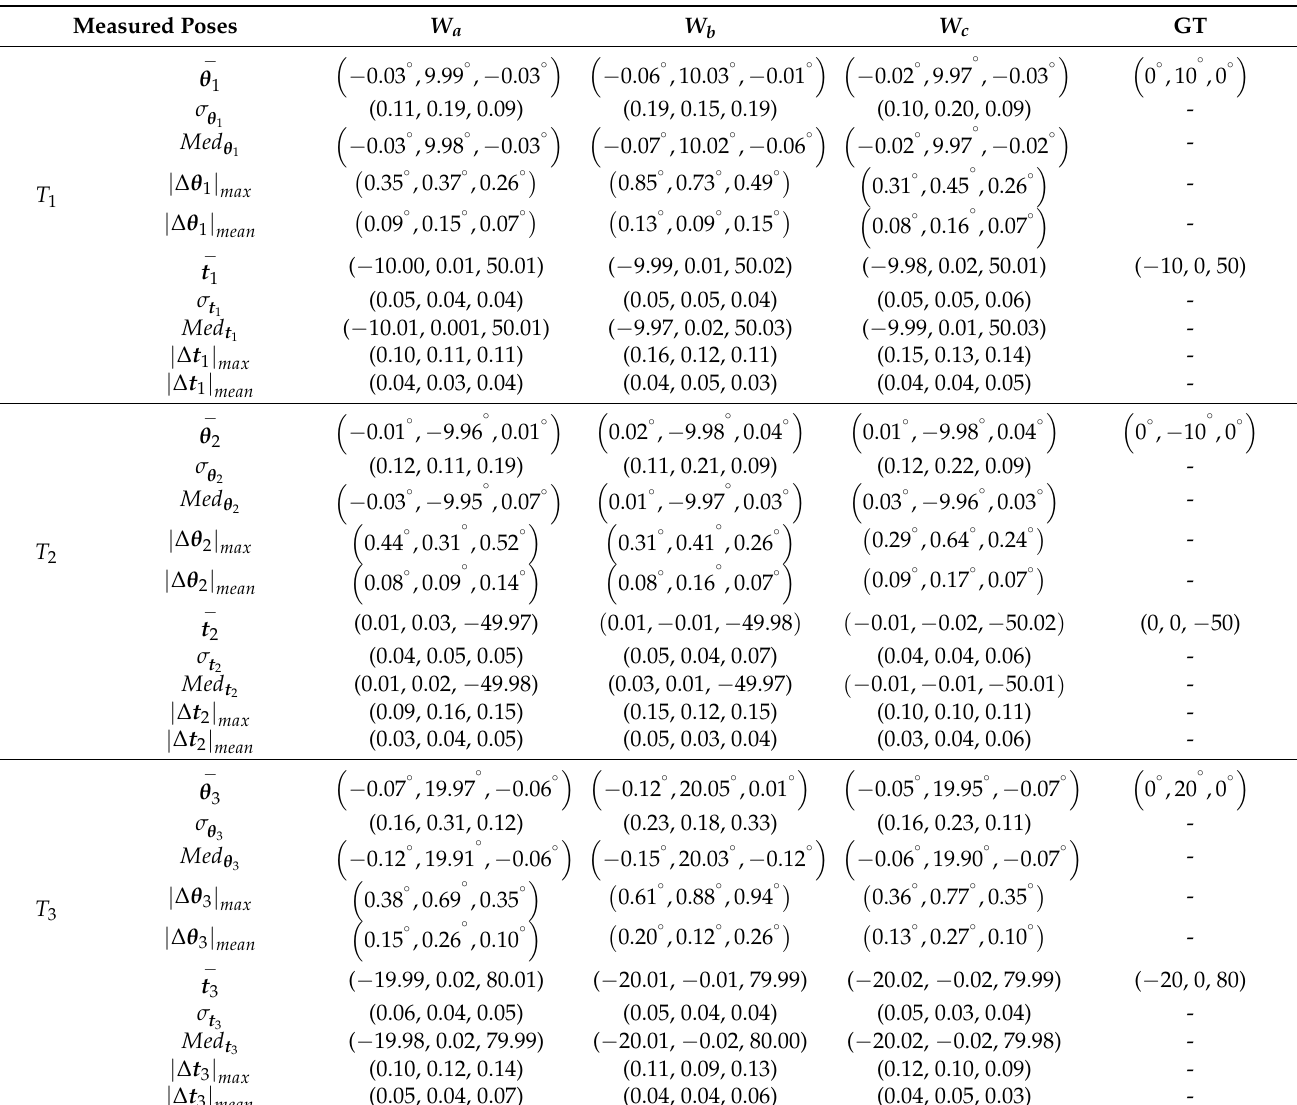
Table 3. Averages, standard deviations, median values, maximum absolute errors, and mean absolute errors of pose measurement results in the camera coordinate system. T 1 , T 2 , T 3 are three pre-defined relative pose transformations. The 3D modeling is carried out at the initial position and the positions transformed by these three pre-defined relative pose transformation matrixes. Pose transformations between two positions can be measured by these 3D models and compared with the ground truths T 1 , T 2 , T 3